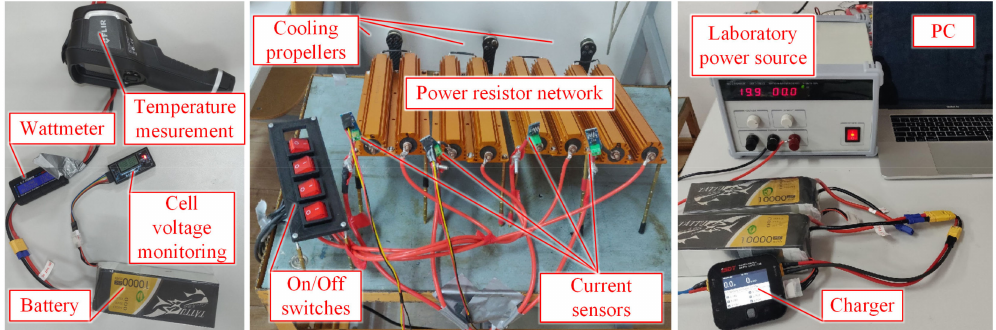
Figure 3. LiPo battery